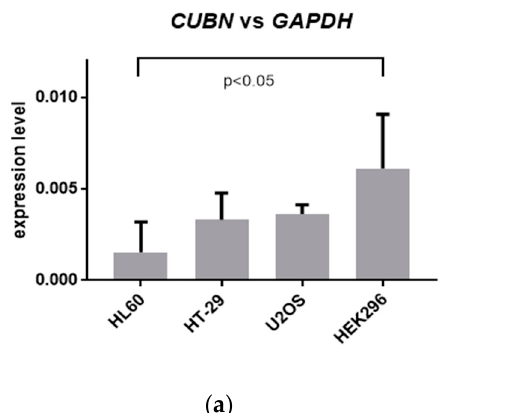
Figure 5. Expression of genes encoding cubilin and megalin in all cells tested. ( a ) The bar charts show the mean values (±SD) of the expression of CUBN mRNA, relative to GAPDH mRNA levels in all cells tested; ( b ) The bar charts show the mean values (±SD) of the expression of LRP2 mRNA, relative to GAPDH mRNA levels in all cells tested. Values that differ significantly from the respective value obtained for HL60 cells are marked with *.